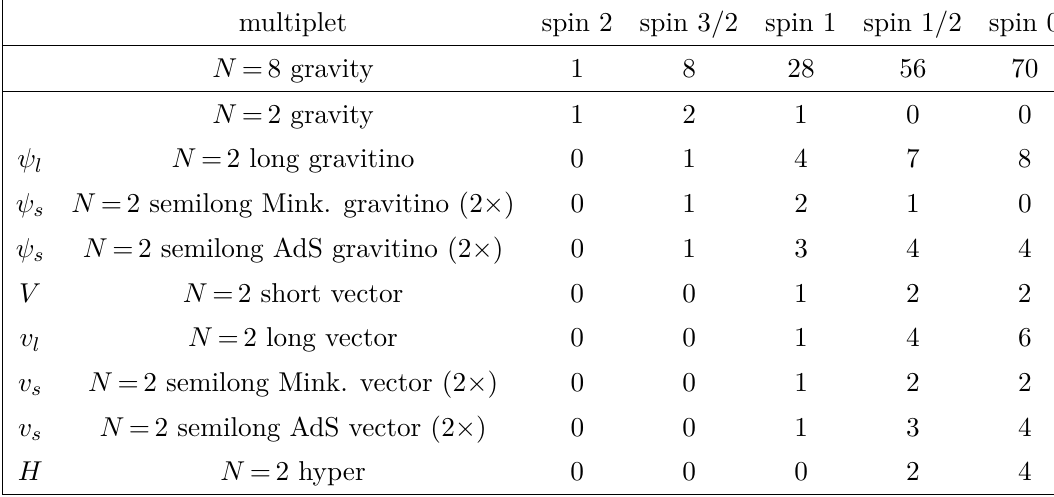
Table 1 . Multiplet content. We listed the states by helicities. For massive multiplets, each massive vector multiplets will eat one of the scalar degrees of freedom and each gravitino will eat one of the spin 1/2 degrees of